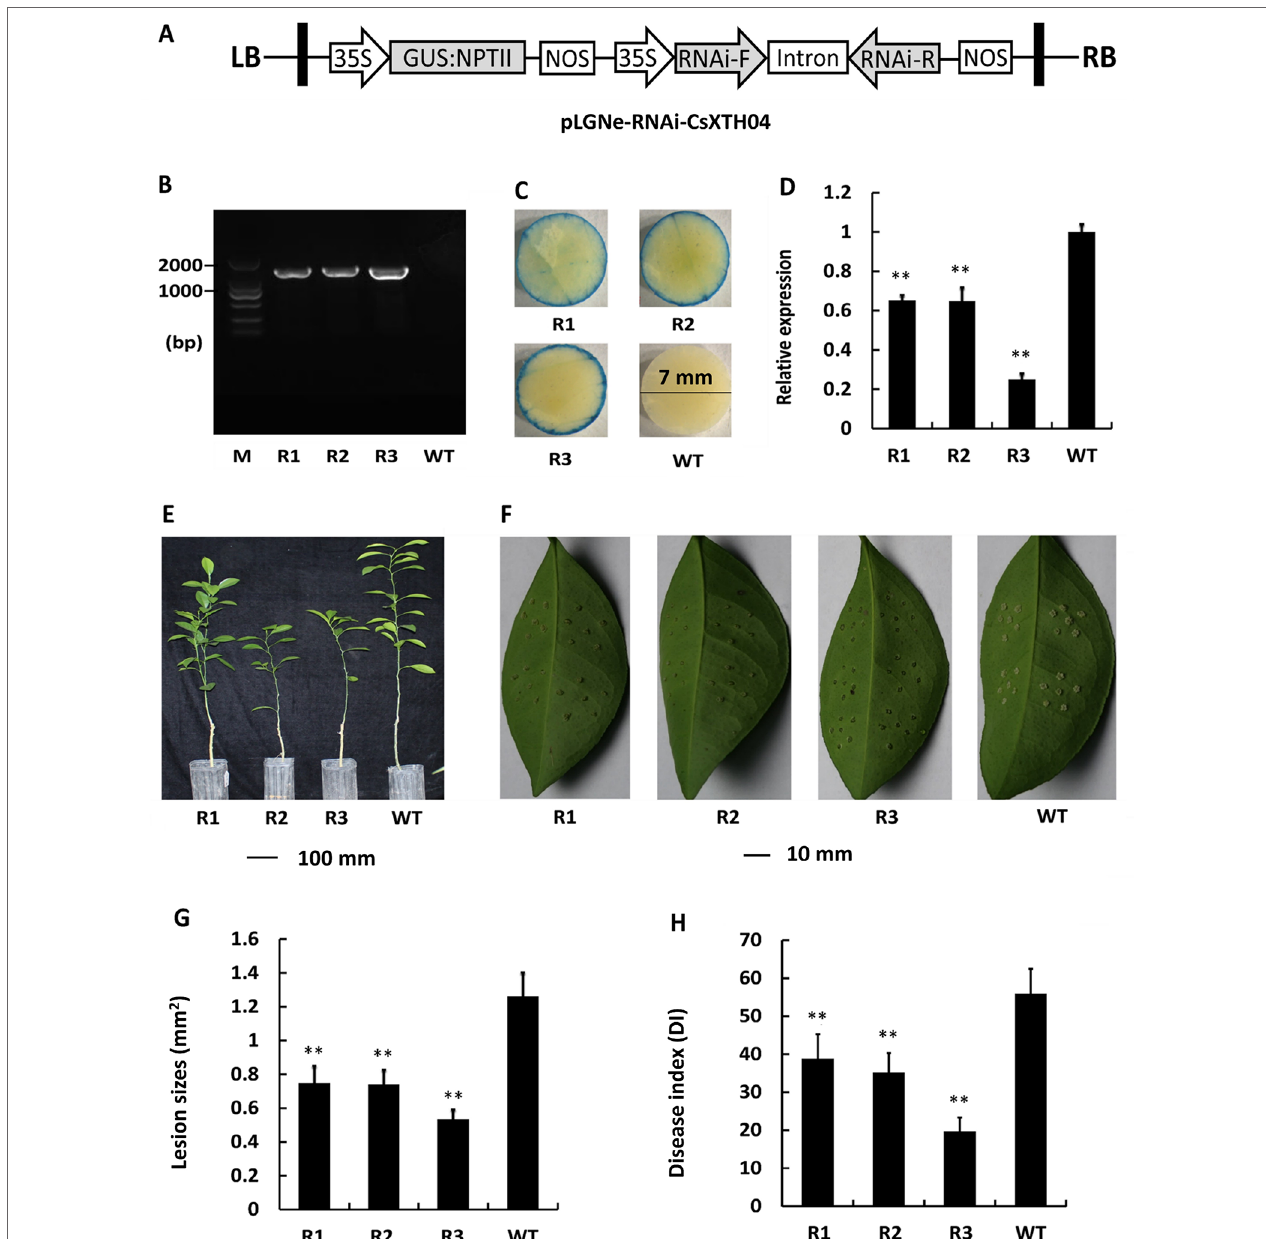
FIGURE 6 | Characterization and evaluation of the silencing of transgenic plants in response to Xcc. (A) Plasmid structures for silencing assays by RNAi (pLGNe- RNAi-CsXTH04). LB, left border; RB, right border; 35S, CaMV35S promoter; NOS, terminator. (B) Validation of transgenic plants by PCR. (C) Validation of transgenic plants by GUS staining (leaf disc diameter = 7 mm, staining period = 24 h). (D) Expression of CsXTH04 detected by qRT–PCR. (E) Phenotypes of transgenic and WT plants. (F) Disease symptoms on the leaves of silenced transgenic plants and WT plants inoculated by Xcc. Sampling and imaging at 10 dpi. Lesion sizes (LSs) (G) and disease index (DI) (H) of each transgenic plant were assessed to evaluate disease resistance. In (D) , (G) , and (H) , ** P < 0.01, Student’s t -test. Each value represents the mean ± SD. In (B) to (H) , R1–R3 indicate silencing plants; WT, wild type. In (B) , M indicates DNA marker. qRT–PCR, quantitative reverse transcriptase–polymerase chain reaction; Xcc, Xanthomonas citri subsp. citri